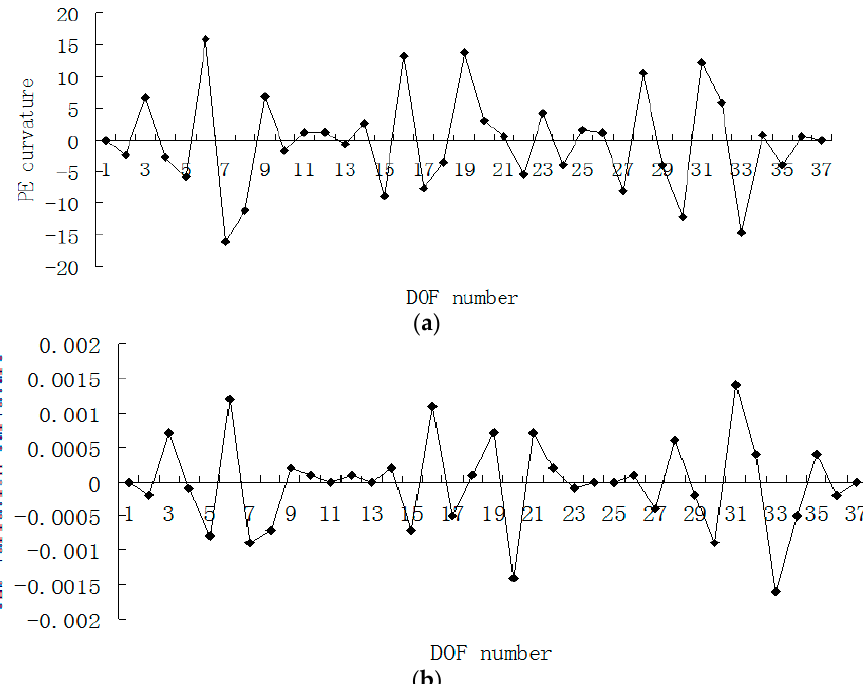
Figure 17. ( a ) Damage index (PE) map using the first four modes with 3% noise when elements 7, 19 and 33 are damaged; ( b ) Damage index (ULS variation) map using the first four modes with 3% noise when elements 7, 19 and 33 are damaged (×10 − 4 ).